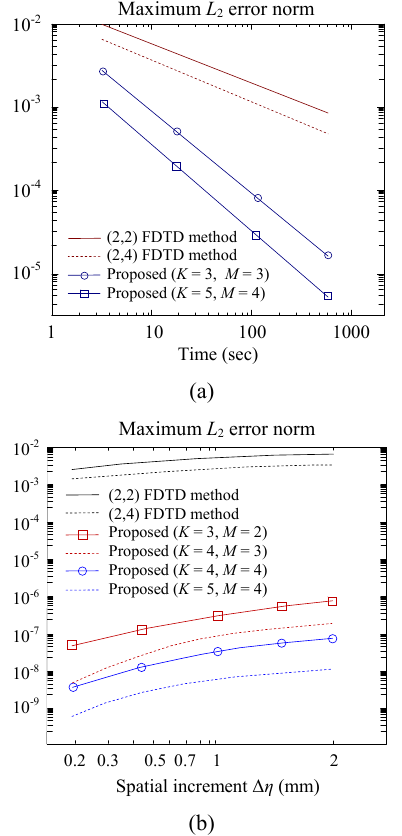
Figure 4: Variation of the maximum L time in sec and (b) spatial increment in